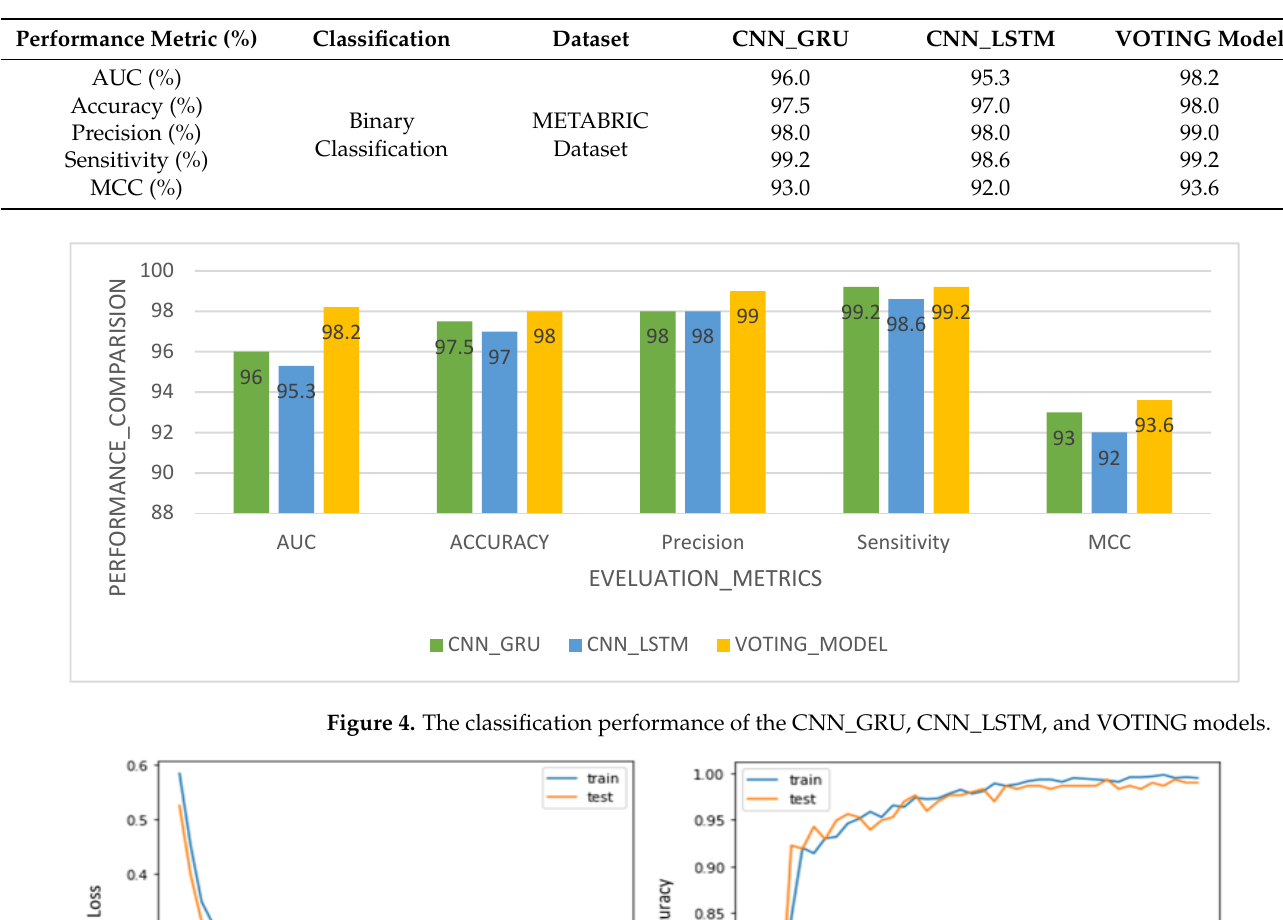
Table 10. The performance of CNN_GRU, CNN_LSTM, and VOTING models with stacked features.